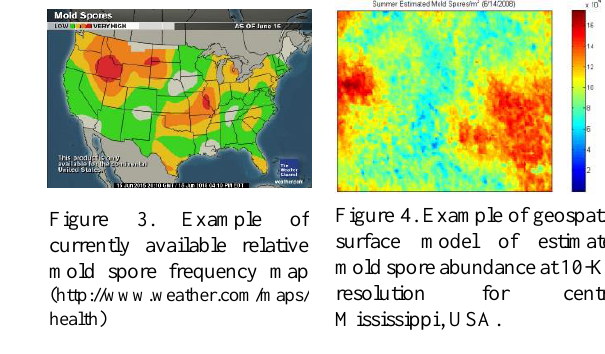
Figure 3. Example of Figure 4. Example of geospatial surface model of estimated mold spore abundance at 10-Km resolution for central